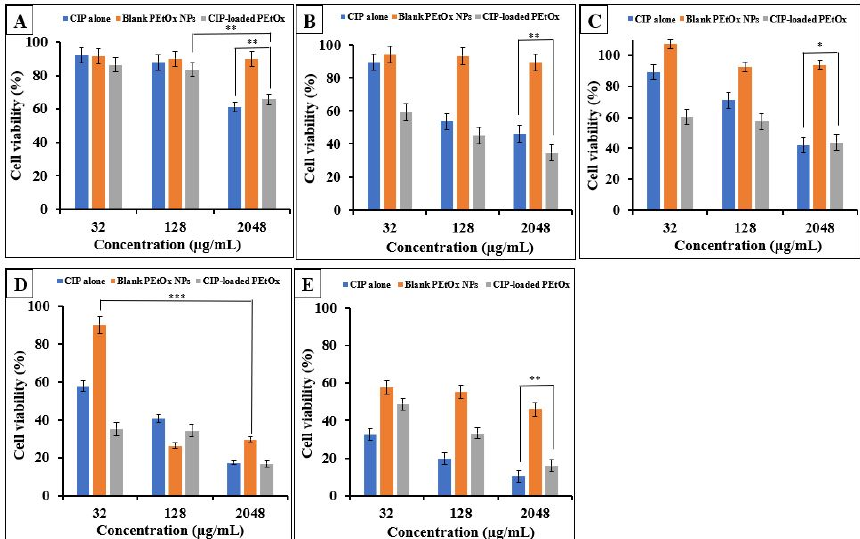
Figure 5. Effect of CIP alone, blank PEtOx NPs, and CIP-loaded PEtOx NPs on cell viability (%) of ( A ) NHBE cells, ( B ) DHBEs, ( C ) CFBE41o- cell line, ( D ) HCs macrophages, and ( E ) CF-like macrophages. p > 0.05 (*), p < 0.05 (**), p < 0.001 (***).